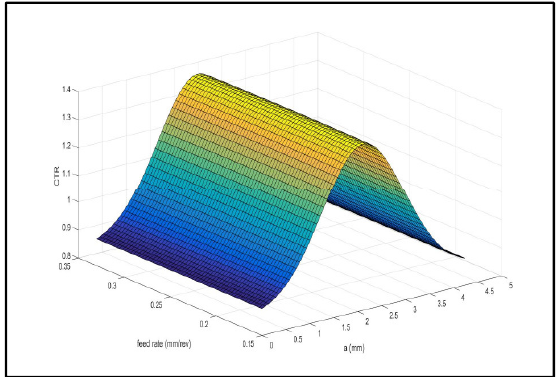
Fig. 9. surface when cutting speed is (683 m/min) &Q